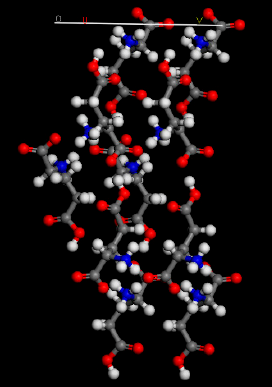
Figure 5. Materials Studio 4.4 (Accelrys)—L-glu (020) crystal plane.